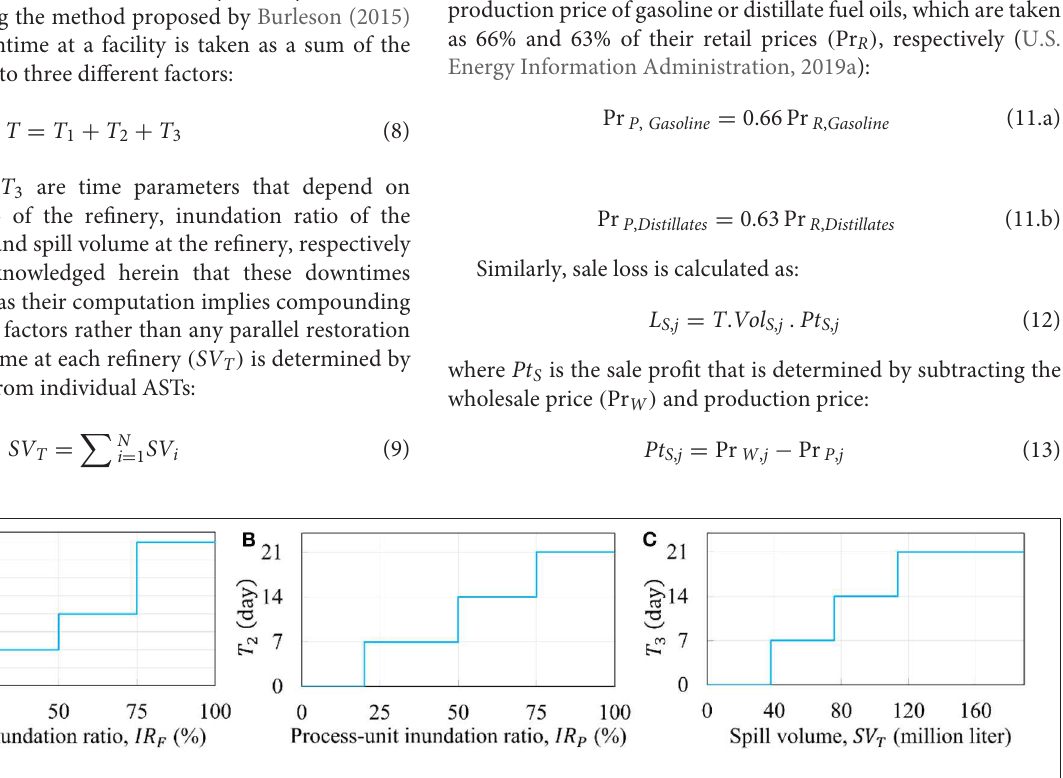
FIGURE 4 | Time parameters in the estimation of refinery downtime due to (A) refinery inundation (B) process-units inundation and (C) petrochemical spill [adopted from (Burleson, 2015)].